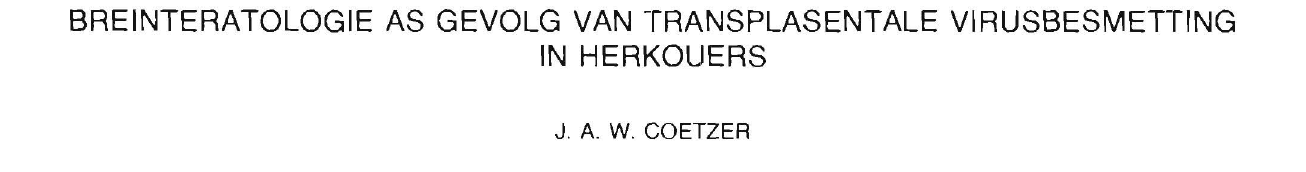
Fig. 1. Brein met opvallende serebellare hlpoplasie Referaat gelewer tydens die Mmi-kongres van die Noord-Transvaal tak van die SA VV. Pretoria. 16 Junie 1979.